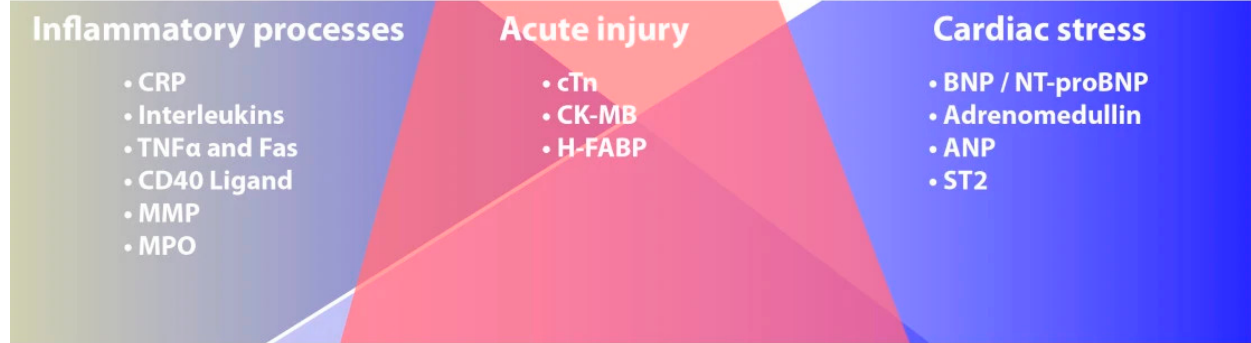
Figure 1. Main cardiac biomarkers and pathophysiological mechanisms involved in their plasma increase. Modified from McLean et al. [8].